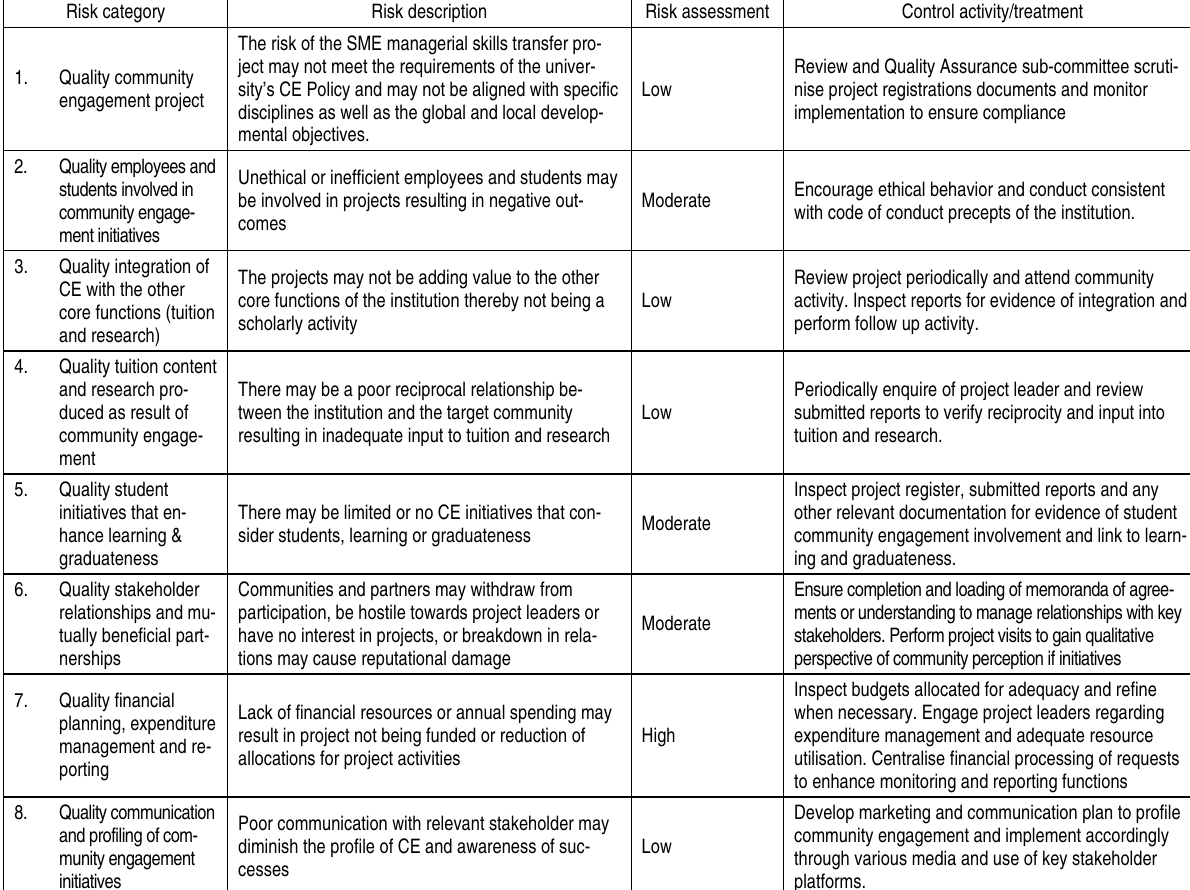
Table 1. Summary of the risks of the SME managerial skills transfer project